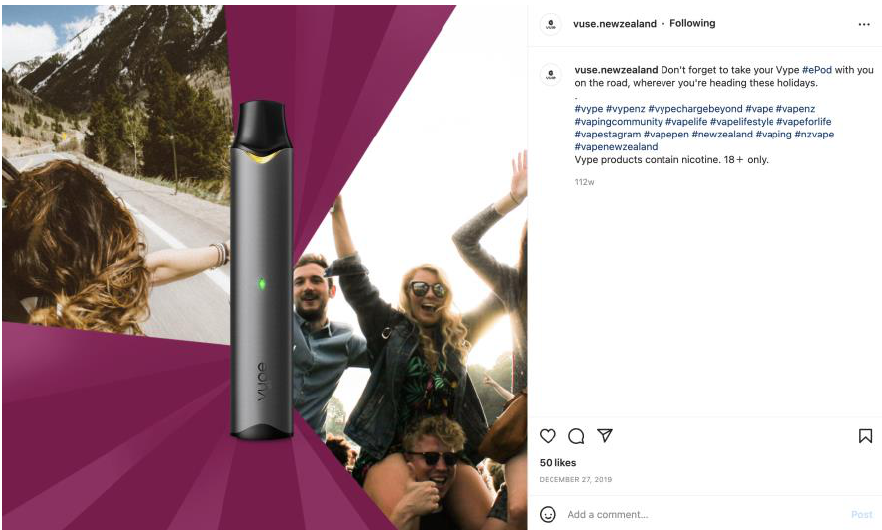
Figure 5. Example of an Instagram posts promoting lifestyle marketing.